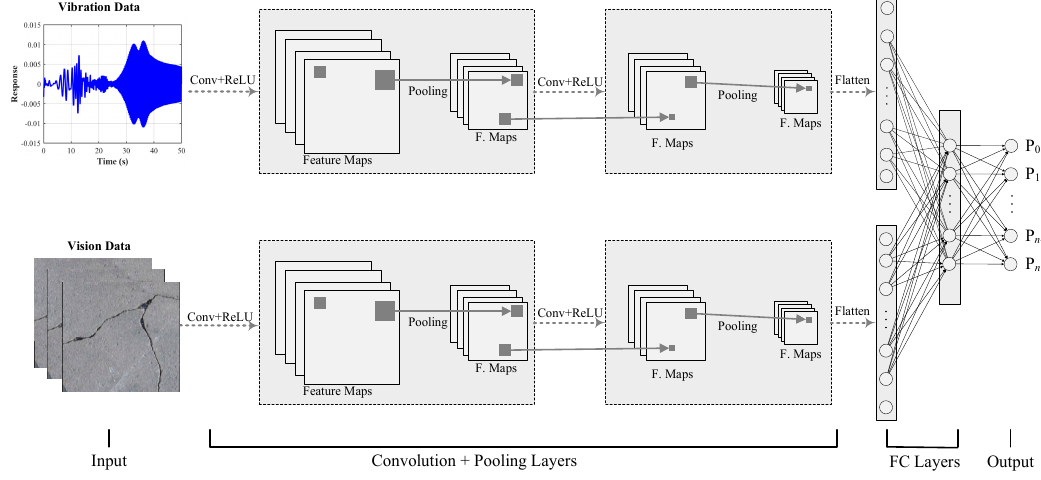
Figure 3. A multi-headed deep neural network for different input data.